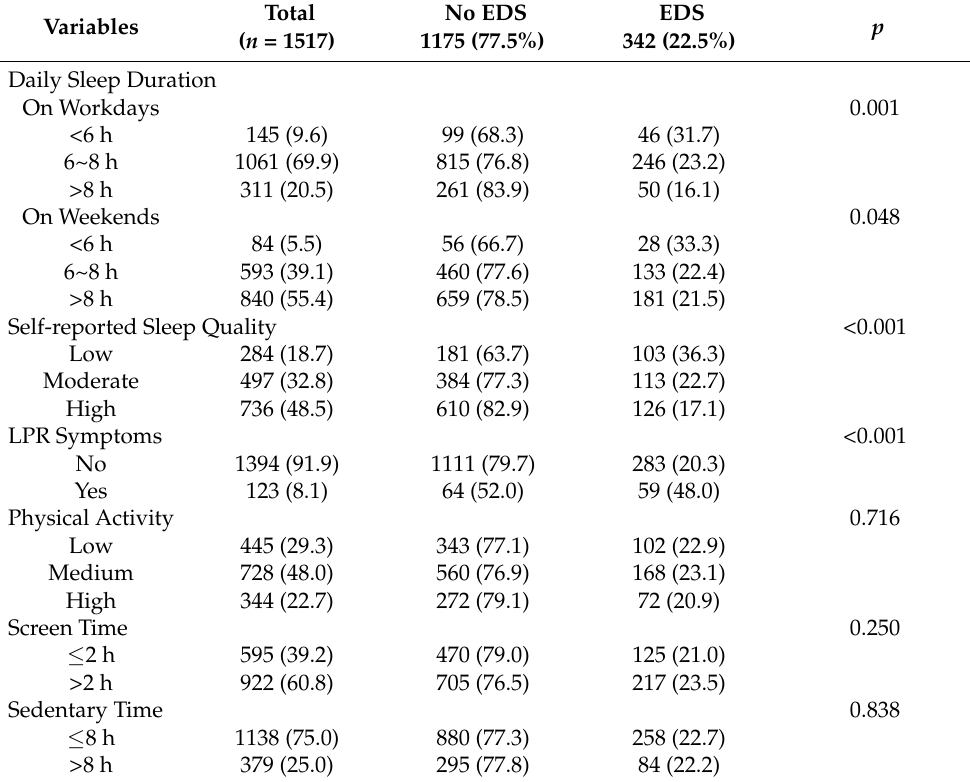
Table A3. Correlates of Sleep by level of EDS ( n = 1517, %). Variables